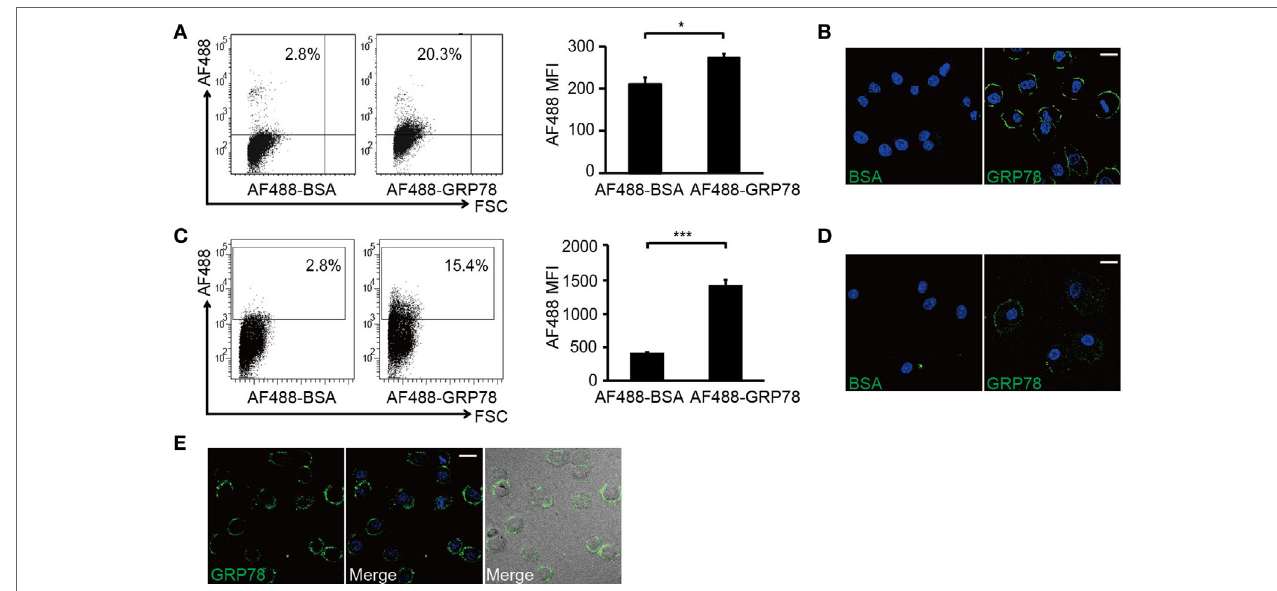
FigUre 2 | grP78 is bound (4°c) but not endocytosed (37°c) by dendritic cells . DC2.4 cells (a,B) or bone marrow-derived dendritic cells (c,D) were incubated with AF488-GRP78 or BSA (1 µM) at 4°C for 1 h. Fluorescence was detected by flow cytometry (FCM) (a,c) or confocal laser scanning microscopy (CLSM) (B,D) . (e) DC2.4 cells were stained with AF488-GRP78 or BSA at 37°C for 1 h. The location of GRP78 was detected by CLSM. Error bars represent mean ± SD from triplicate samples in one experiment. * P < 0.05 and *** P < 0.001. All images for all panels are representative of at least three independent experiments in which > 100 cells were examined and > 95% of cells showed similar staining. Scale bar, 20